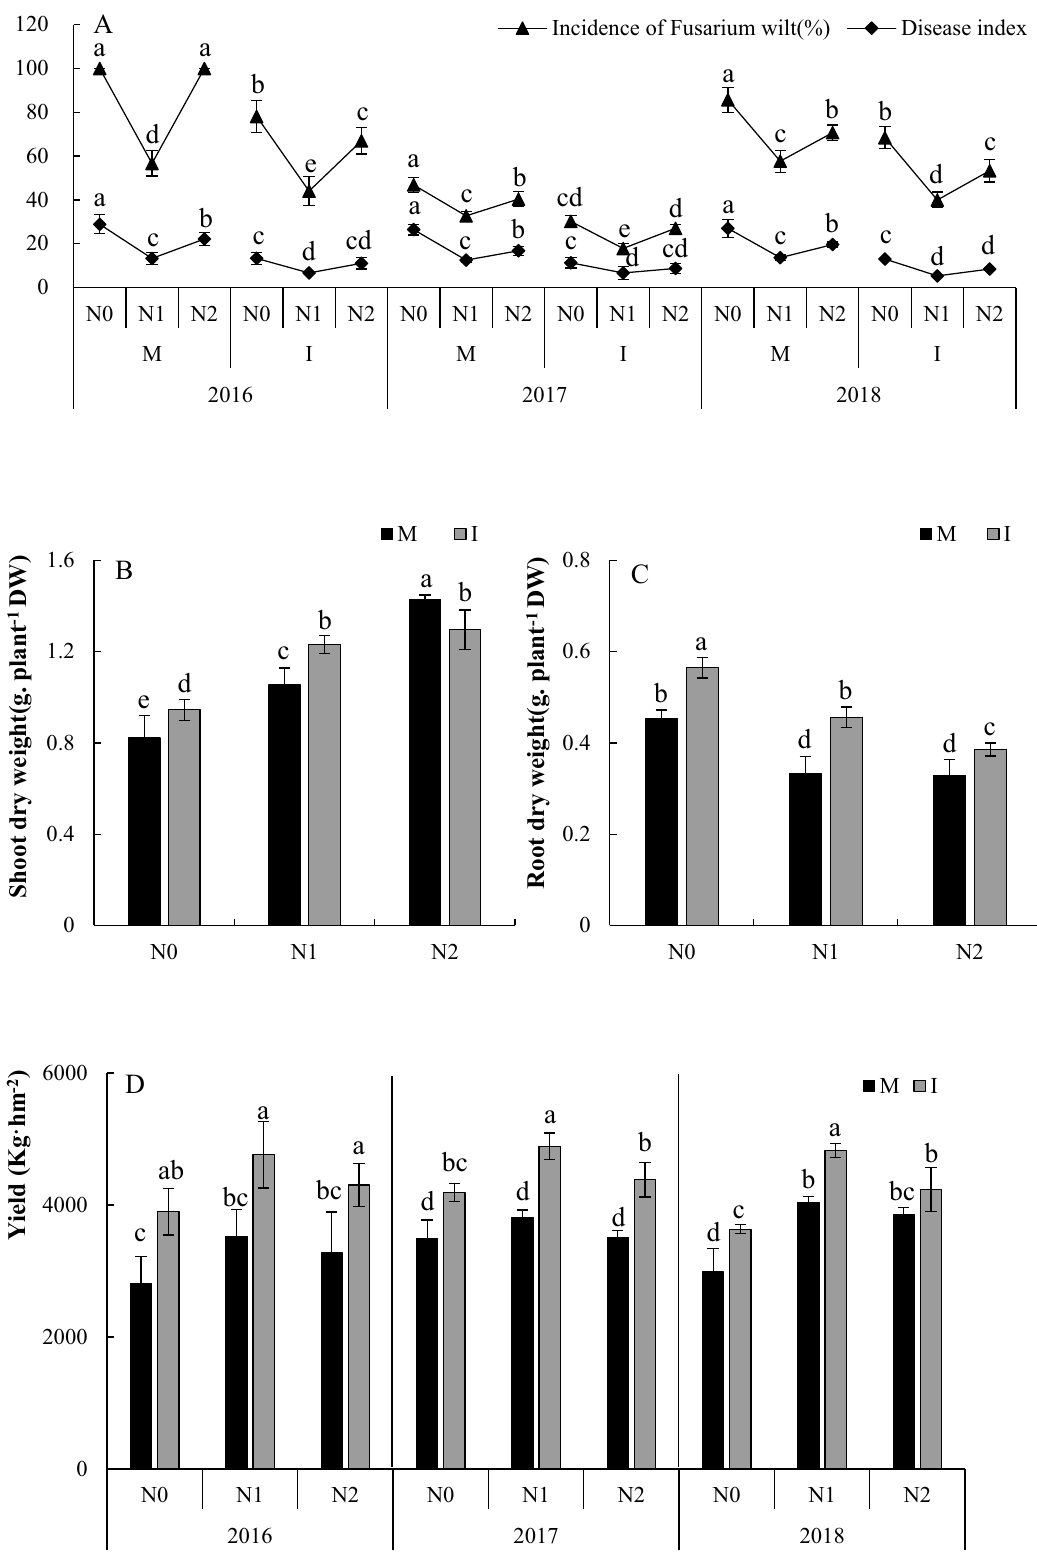
Figure 3. ( A ) Incidence and disease index of Fusarium wilt; ( B ) Faba bean shoot dry weight; ( C ) Faba bean root dry weight. ( D ) Yield of faba bean. All the values are presented as the mean ± SE. The different letters on the mean values of the same day indicate significant differences among the treatments ( P <